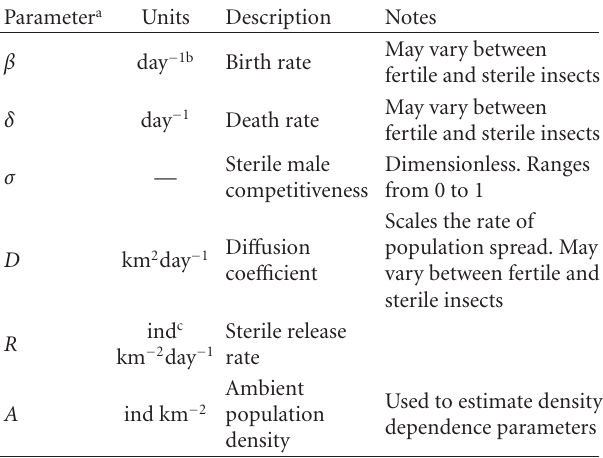
Table 1: Biological dispersal model parameters used in the models to estimate a minimum area for an area-wide IPM program, including the sterile insect